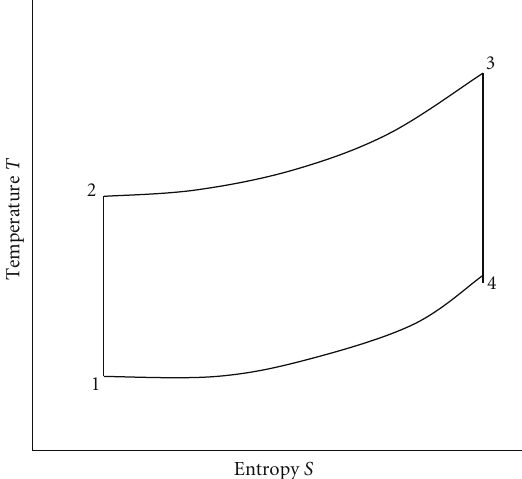
Figure 1: P-V diagram of the theoretical air standard Atkinson cycle. Figure 2: T-S diagram of theoretical air standard Atkinson